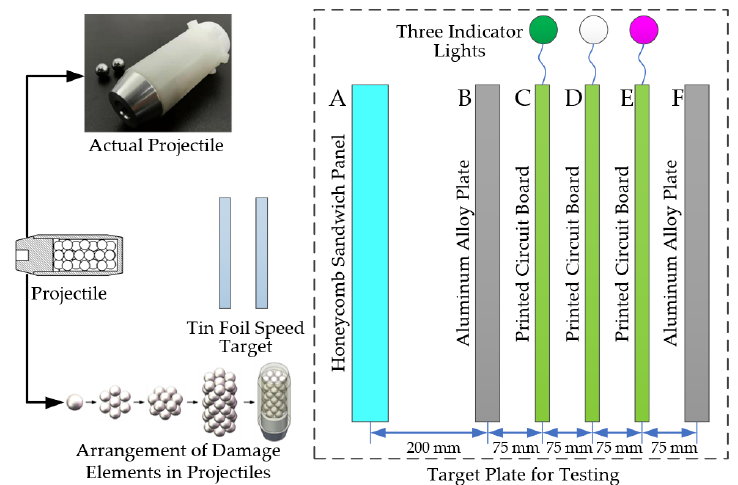
Figure 1. Schematic diagram of the layout of the ground test.